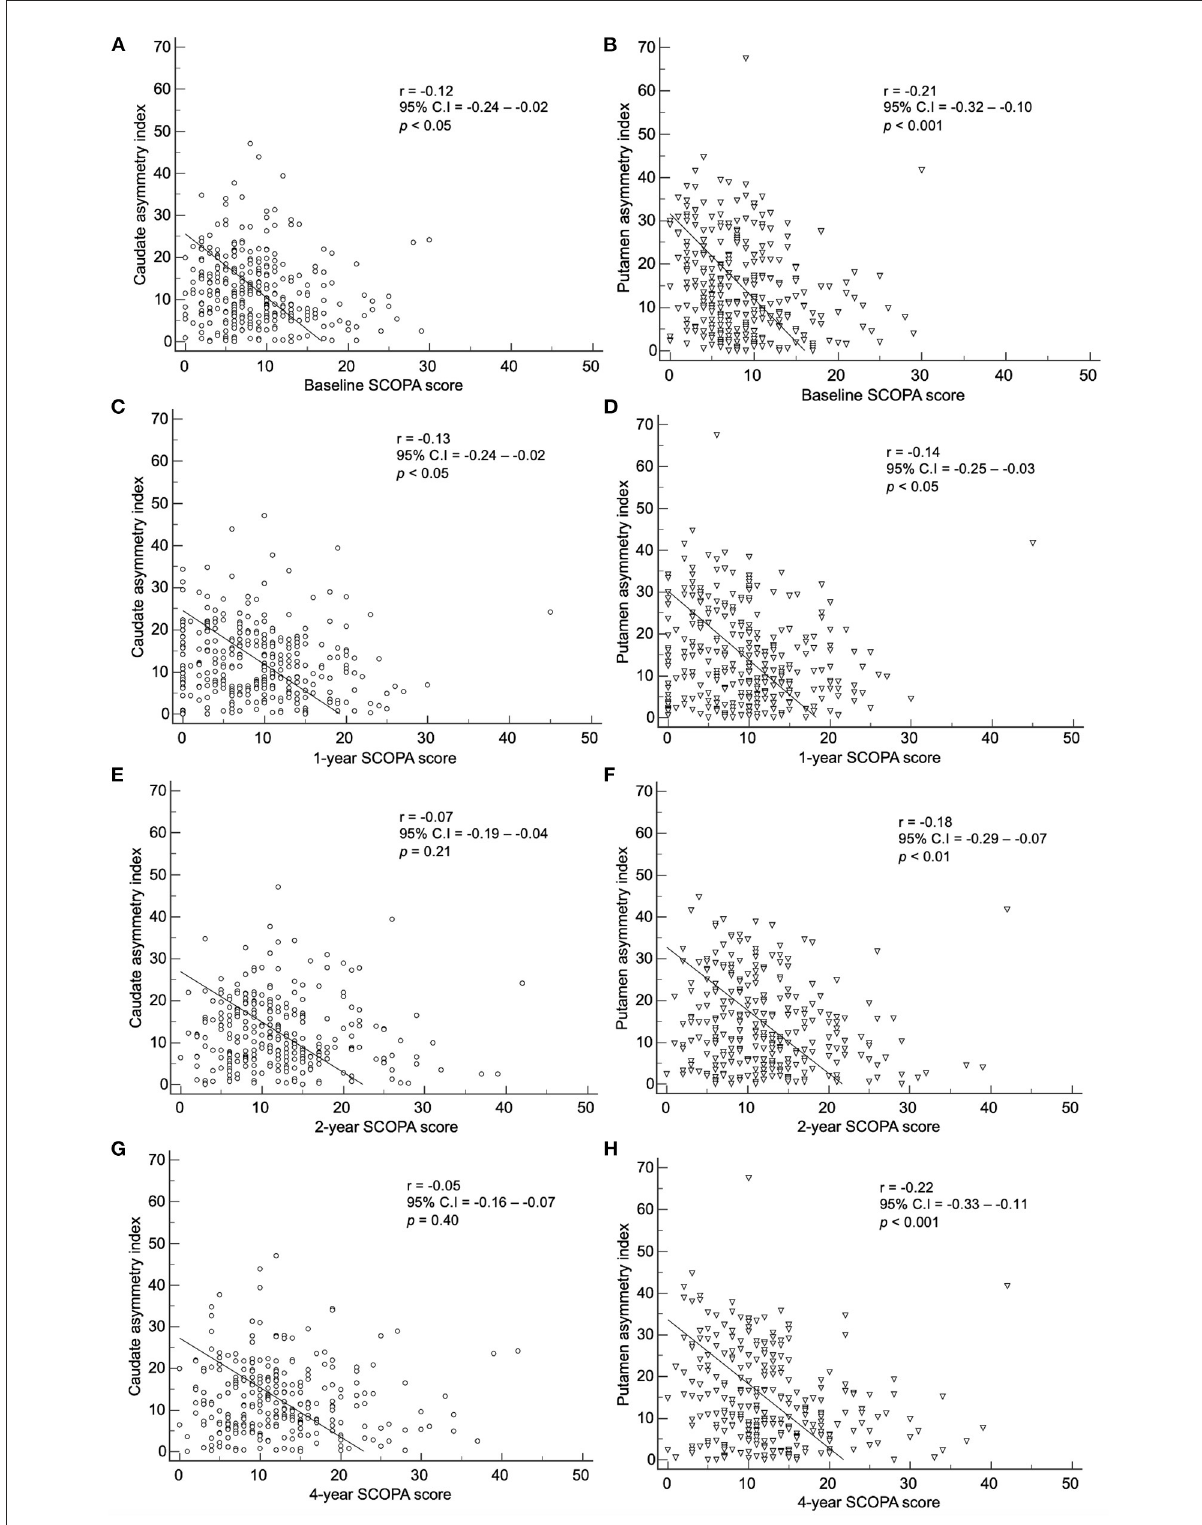
FIGURE7 Correlation of the baseline asymmetry index of the caudate by method 2 with (A) baseline, (C) 1-year, (E) 2-year, and (G) 4-year SCOPA scores. Correlation of the baseline asymmetry index of the putamen by method 2 with (B) baseline, (D) 1-year, (F) 2-year, and (H) 4-year SCOPA